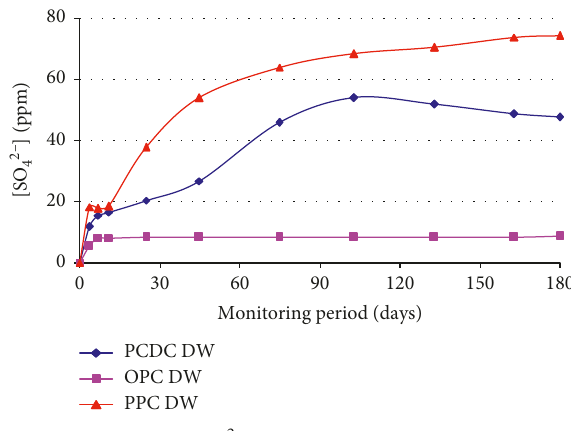
analyses in distilled water. −